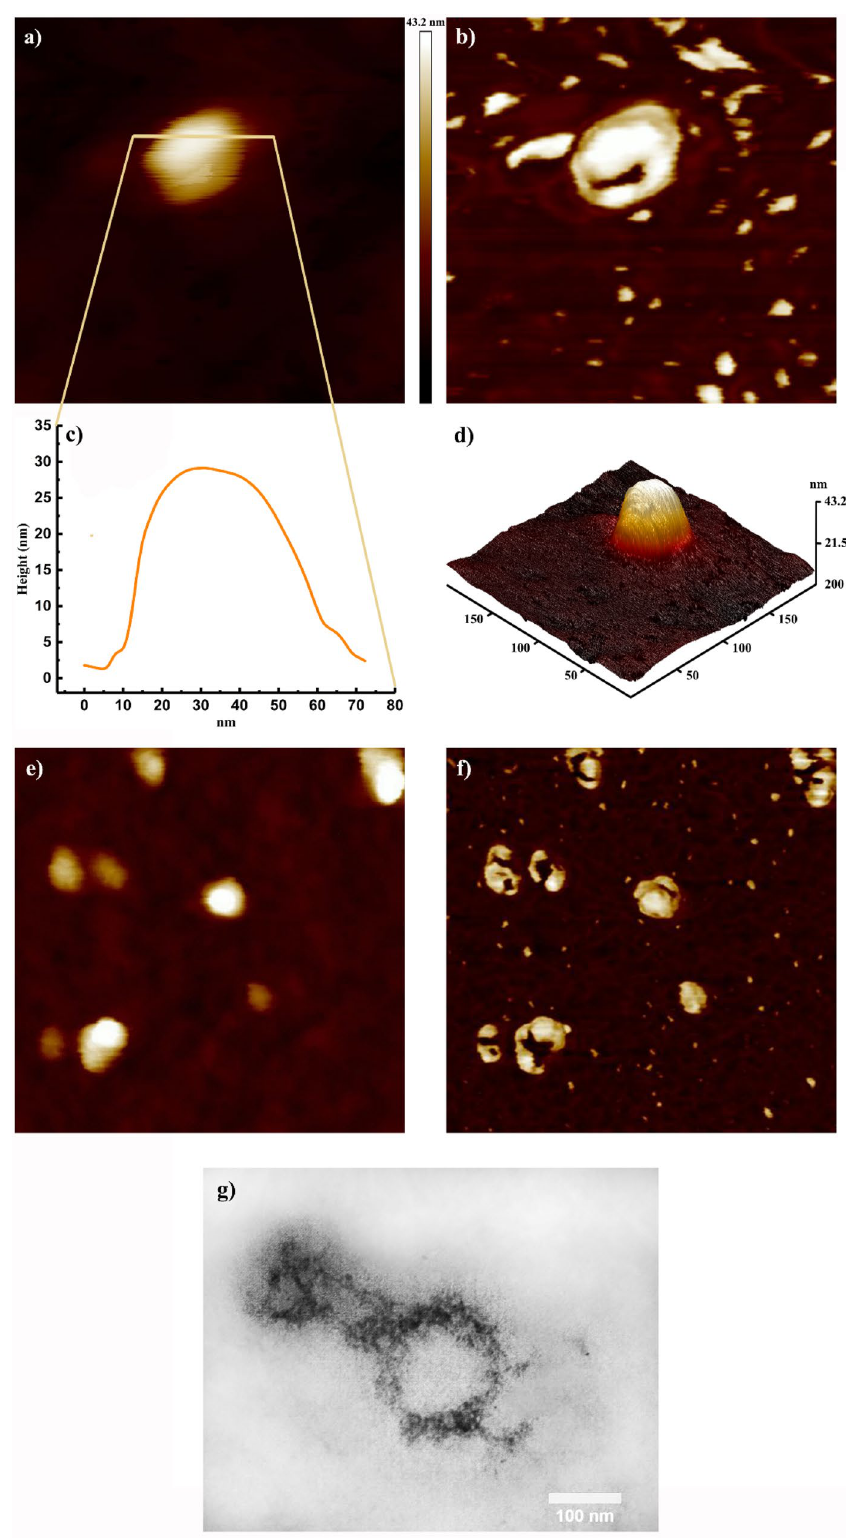
Figure 2. Topographic AFM image of the ozone treated SARS-CoV-2 particle on Glu-UD-Si(100) surface: ( a ) 2D image of a single virus particle (200 × 200 nm), ( b ) AFM phase image of a single virus particle with the virus debris (200 × 200 nm), ( c ) The corresponding height profile of the virus, ( d ) 3D image of the same virus, ( e ) AFM height image of the virus particles (500 × 500 nm), ( f ) AFM phase image (500 × 500 nm), and ( g ) Transmission electron microscopy imaging of ozone treated SARS-CoV-2. A negative-stained virus particle shows features of coronaviruses (60,000